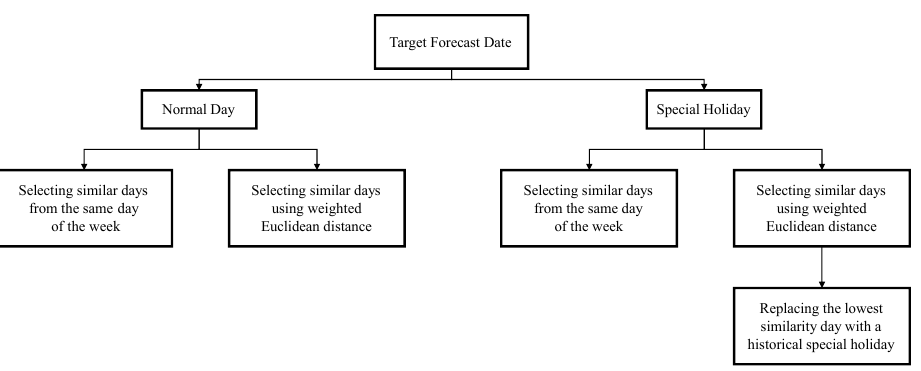
Figure 5. The new similar days selection criterion considering historical peak load, day of the week, and special days.